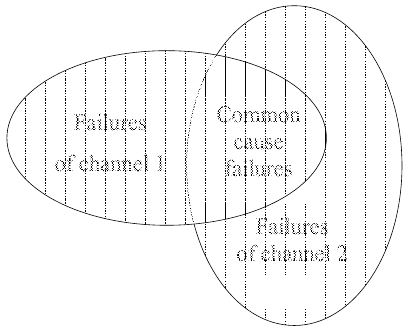
Figure 13. Programmable electronic system with two channels.